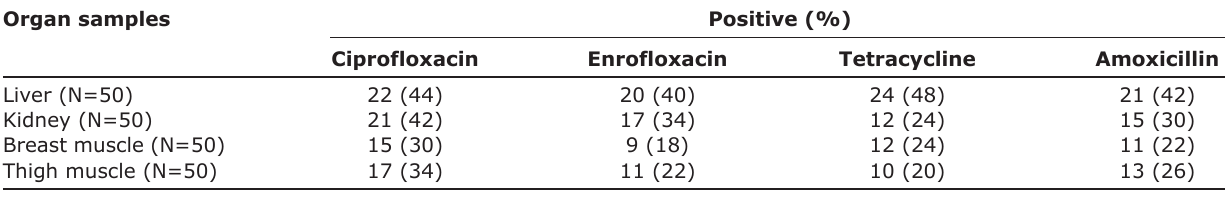
Table-1: Overall percentages of different antibiotics residue in different tissue of broiler and layer. Organ